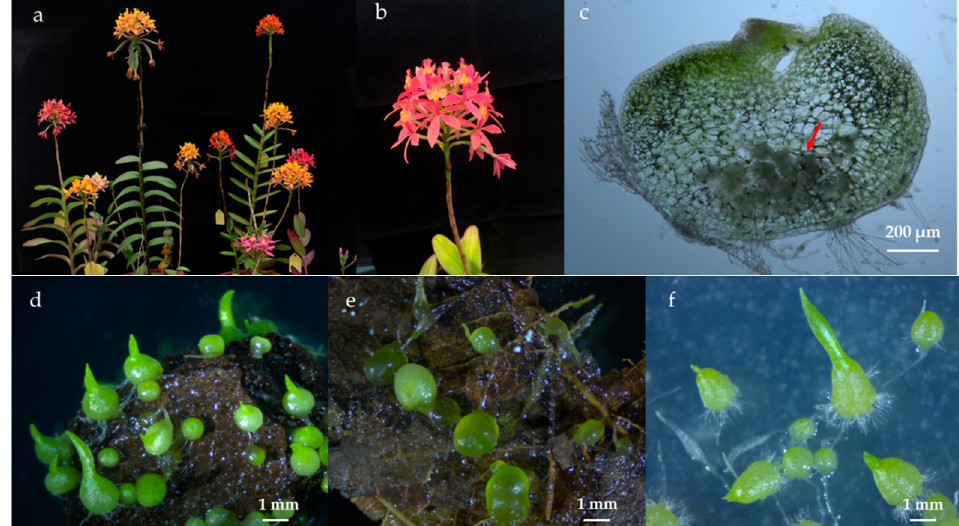
Figure 1. Flowers of Epidendrum spp. ( a ) and E. radicans ( b ); colonization of fungi in protocorm after symbiotic germination ( c ); protocorms ex situ germinated on pine bark ( d ) and rotten oak leaf ( e ) after 10 weeks of seed baiting; protocorms in vitro germinated on MS1 medium ( f ). The red arrow indicates the intracellular fungal peloton.